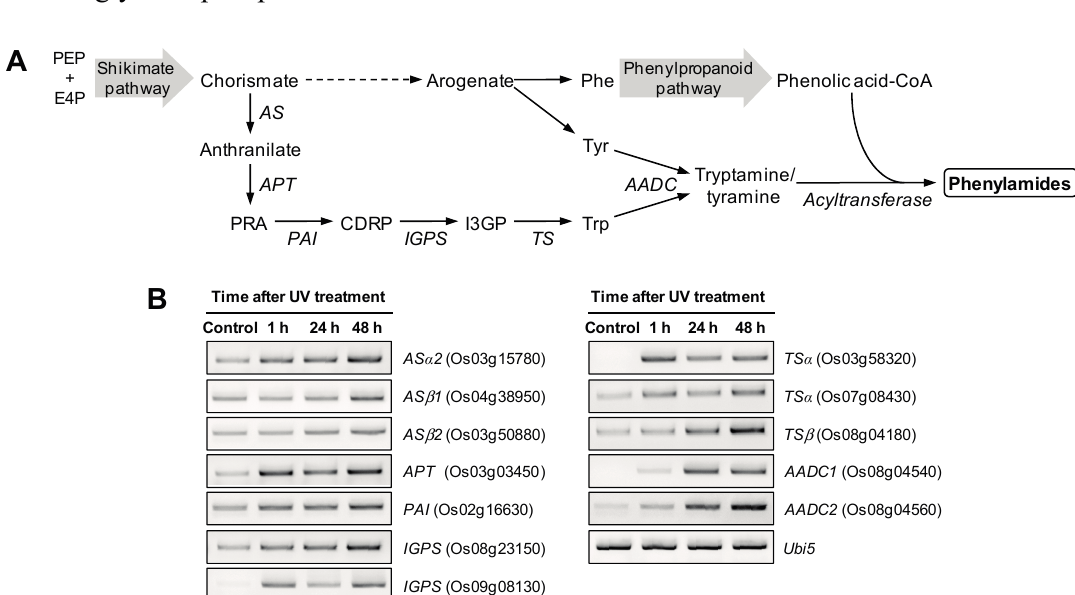
Figure 3. Activation of the phenylamide biosynthetic pathways in response to UV treatment. ( A ) Biosynthetic pathways in the UV-induced phenylamide production. ( B ) UV-induced expression of arylamine biosynthetic genes possibly involved in phenylamide